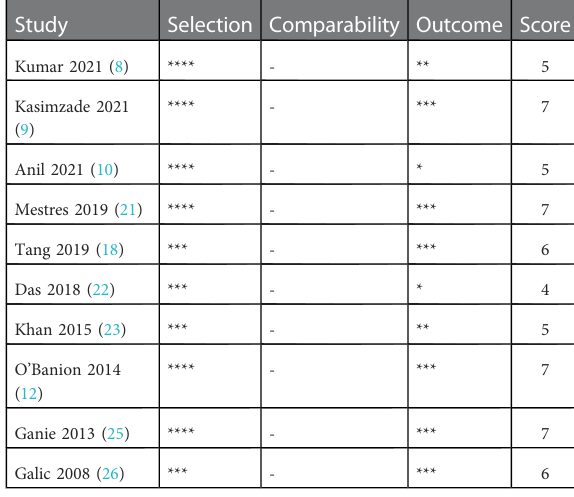
TABLE 5 Risk of bias analysis of non-RCTs.